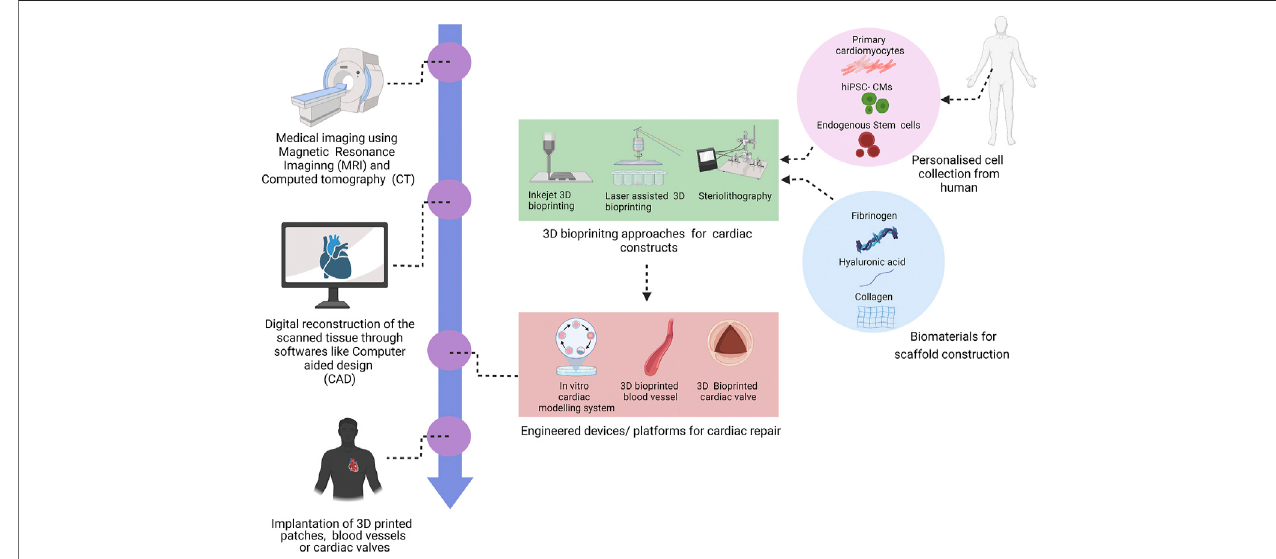
FIGURE 1 | 3D bioprinting technology for cardiac repair and regeneration.